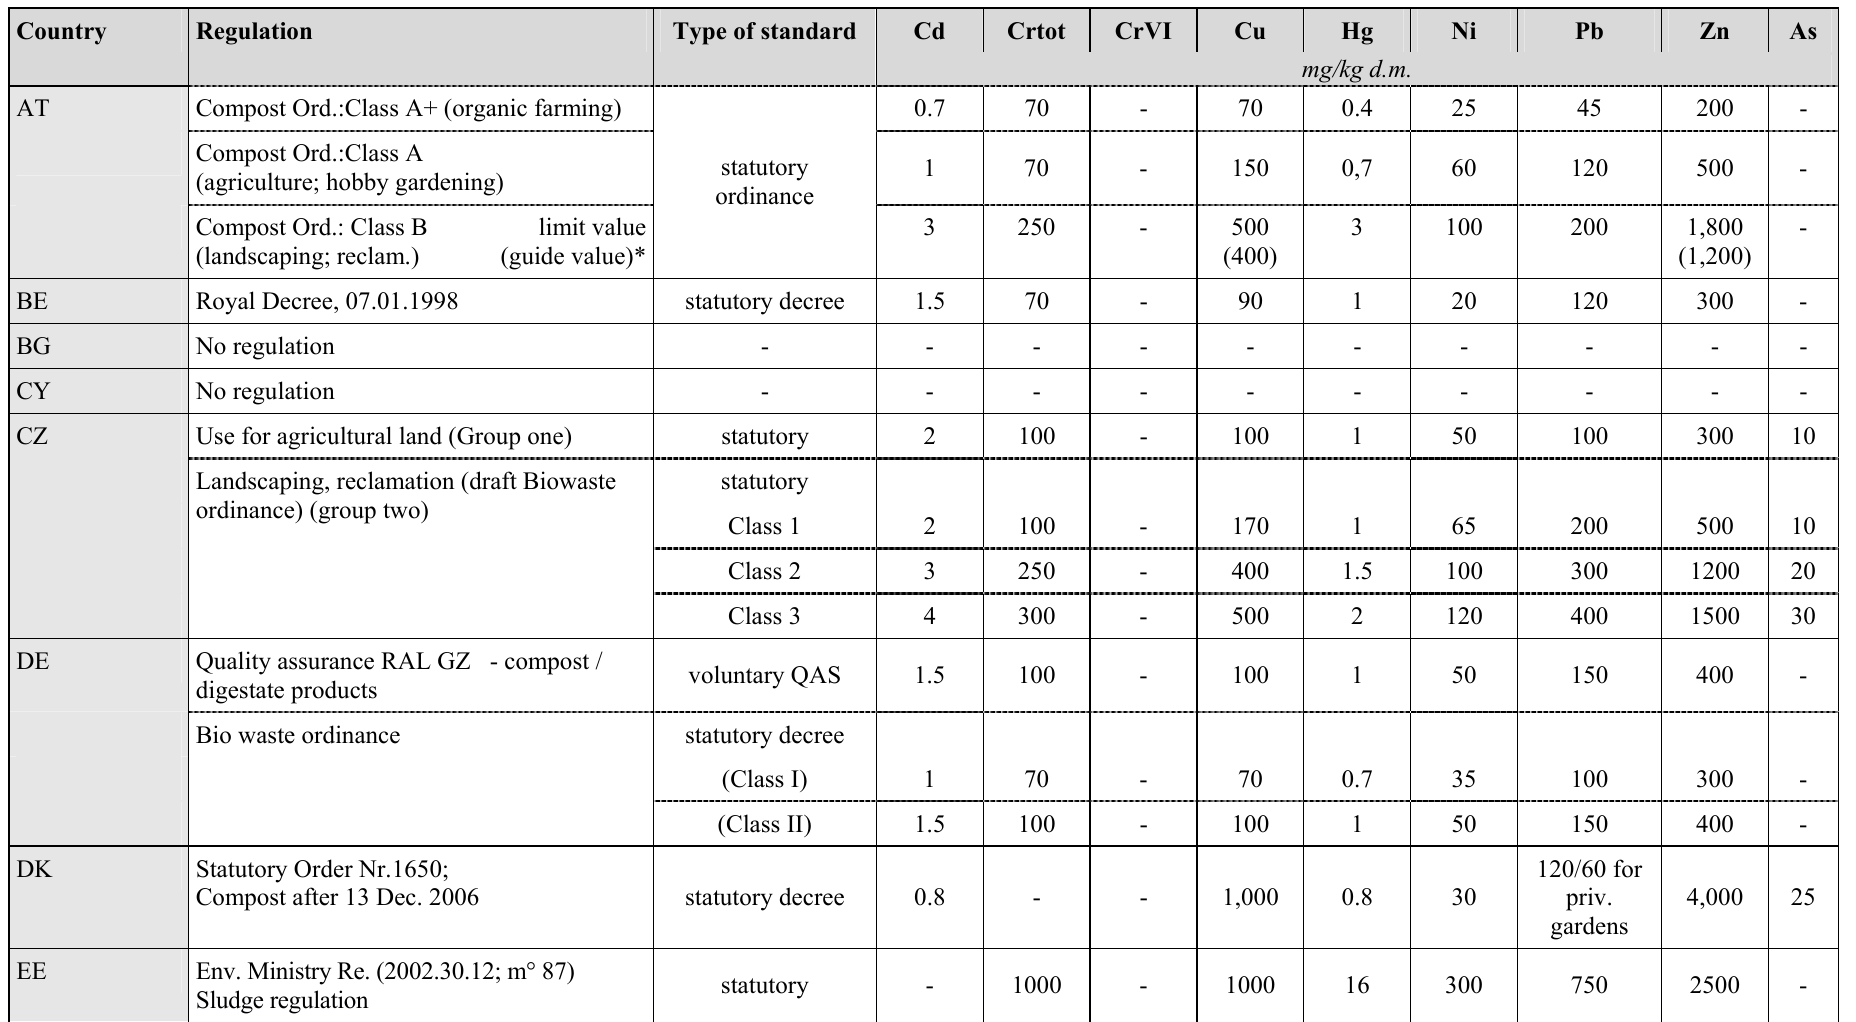
Table 15: Heavy metal limits in European compost standards Regulation Type of